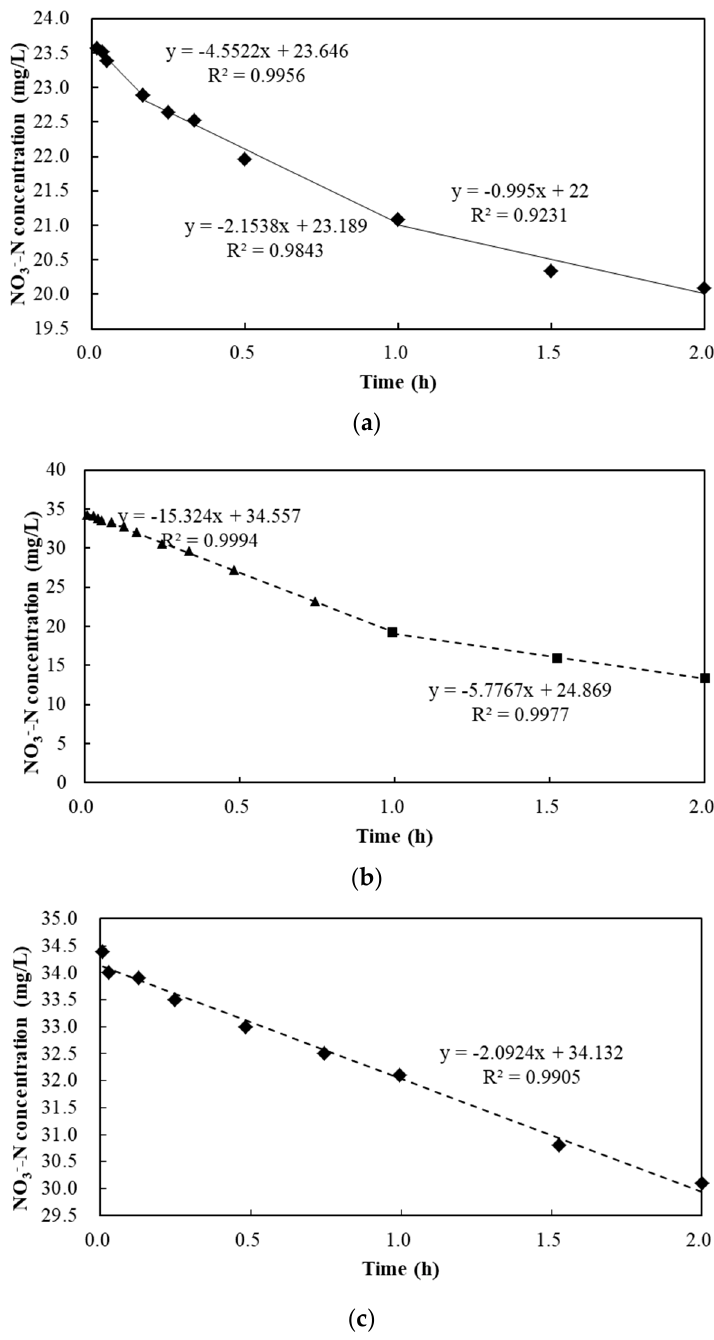
Figure 8. ( a ) The denitrification rate of activated sludge in the CAST process (average denitrification rate is below 3.0 mg/gVSS·h in China); ( b ) The denitrification potential rate of activated sludge in the CAST process; and ( c ) The endogenous denitrification rate of activated sludge in the CAST process. Table 1. The denitrification rate of activated sludge in the CAST process.